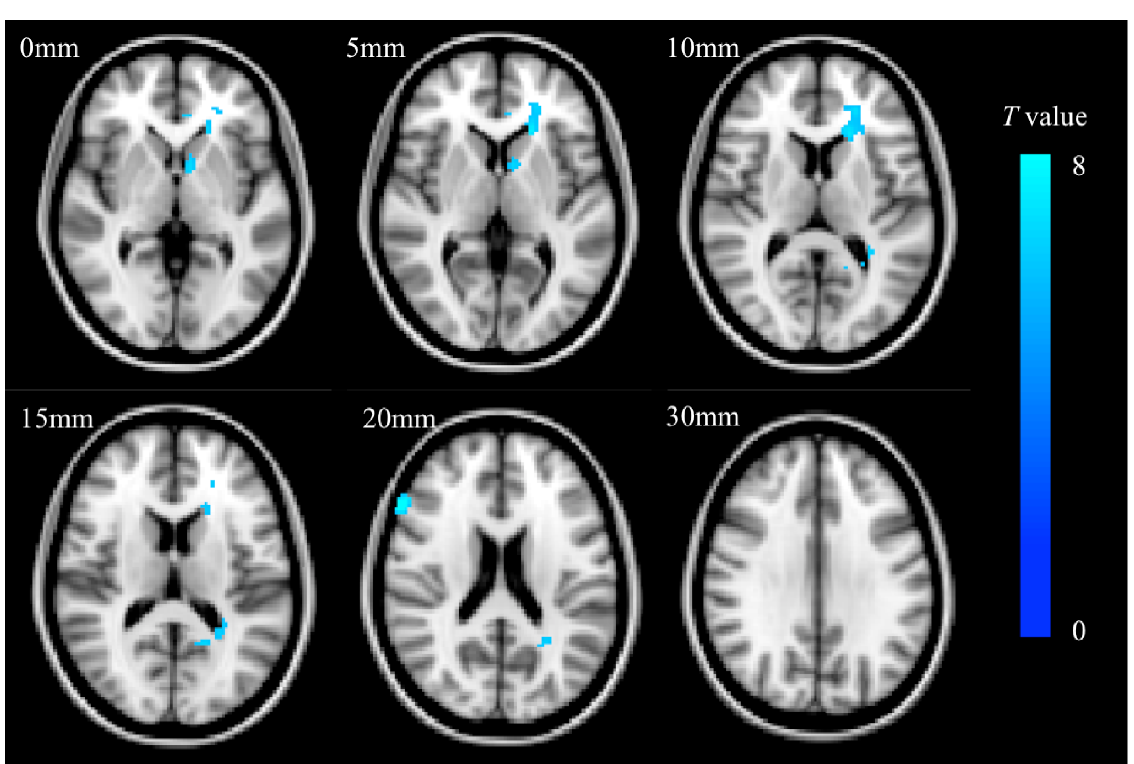
Fig. 1. Overlap of standard-space brain regions with significantly lower FA in patients with post-stroke apathy. Colors map the t -values. Slice thickness 5 2 mm, L: left; R :